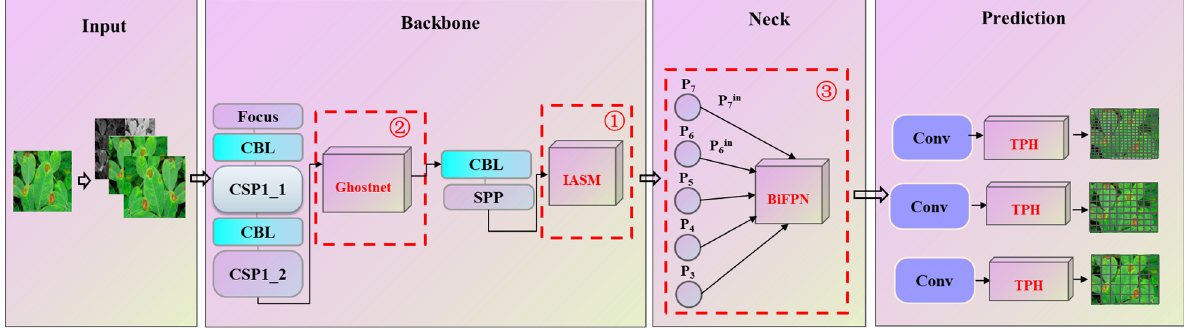
Figure 10. The structure of the optimized lightweight YOLOv5 model proposed in this study (including the three proposed improvements). (Added IASM ( ① ), Ghostnet ( ② ) and BiFPN ( ③ ) to the original model).